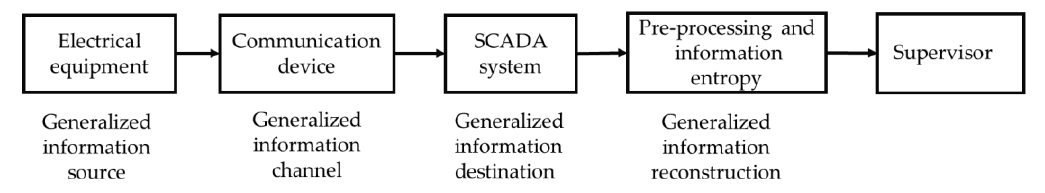
Figure 2. Information transmission in a power system. SCADA: Supervisory Control and Data Acquisition.